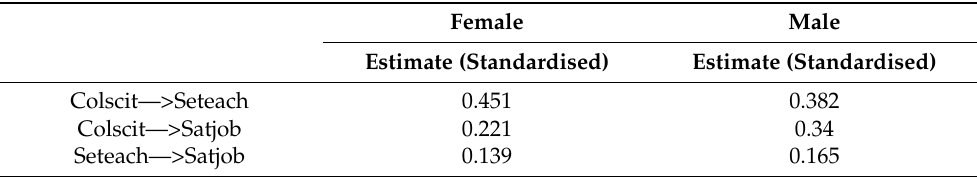
Table 8. Effect of multi-group SEM model by